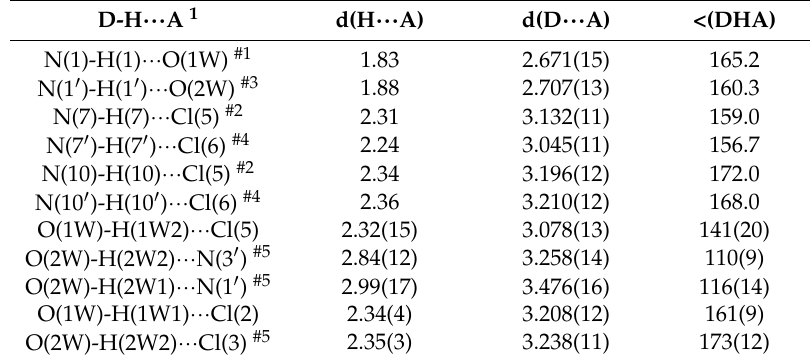
Table 1. Geometric features of the hydrogen bonds in compound 3 . Distances in Å and angles in degrees.